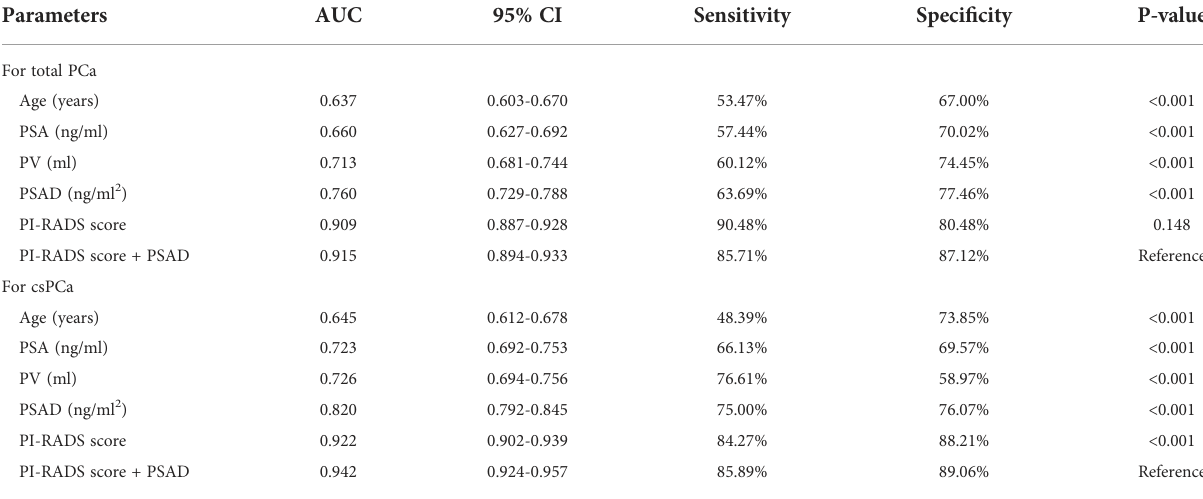
TABLE 2 Diagnostic accuracy of the clinical parameters for total PCa and csPCa. Parameters